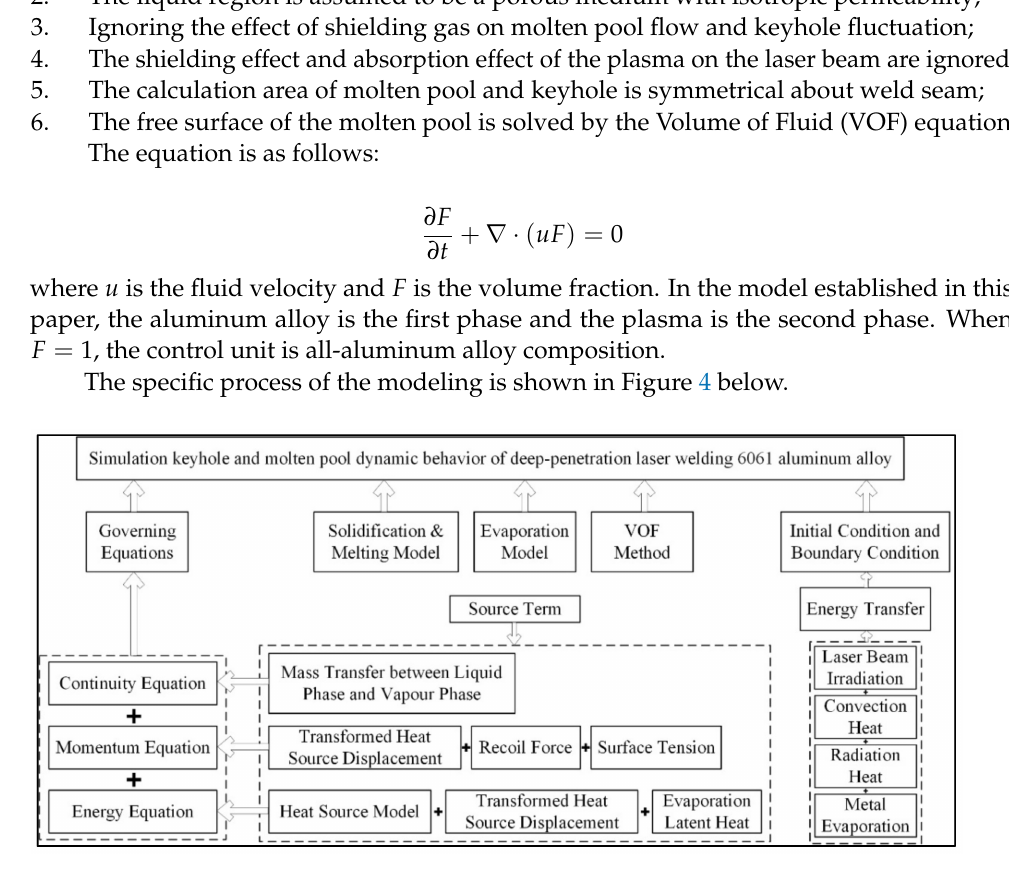
Figure 4. Schematic diagram of numerical model